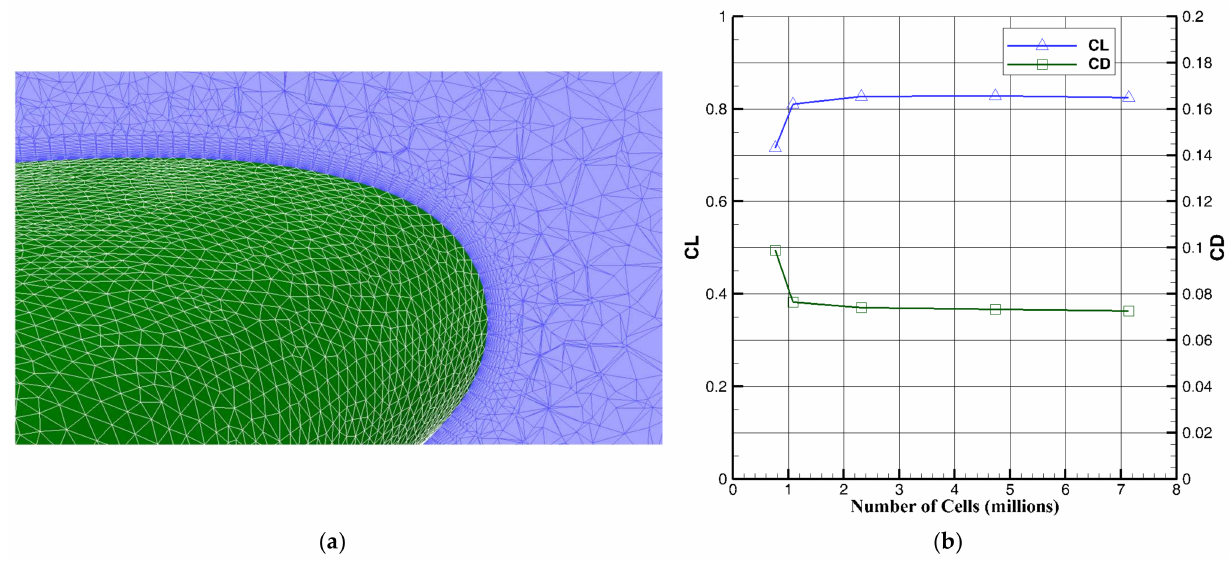
Figure 8. Mesh study. ( a ) The generated mesh in the vicinity of wing leading edge; ( b ) the C L and C D mesh independency in the clean configuration at α = 10 ◦